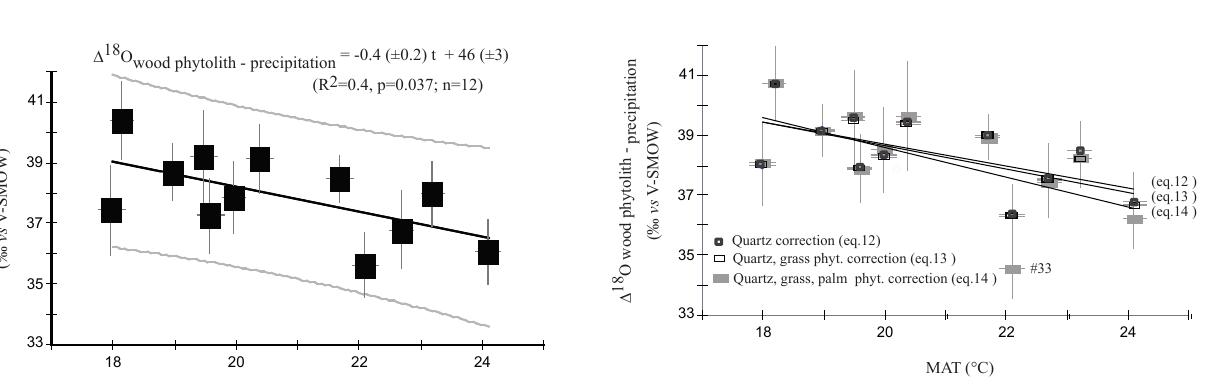
Fig. 4. δ 18 O wood phytolith values (corrected for the presence of quartz) vs. altitude, mean annual temperature (MAT), mean annual precip- itation (MAP) and estimated amount weighted mean annual δ 18 O precipitation values. Error bars refer to uncertainties on δ 18 O precipitation , δ 18 O wood phytolith , MAP and MAT (Sects. 4.3, 4.4 and 4.5). Diamonds: points from Bartle Frere; squares: other points. A linear positive correlation appears between δ 18 O wood phytolith and δ 18 O precipitation values ( R 2 =0.5) when points from Bartle Frere transect (squares) are excluded.